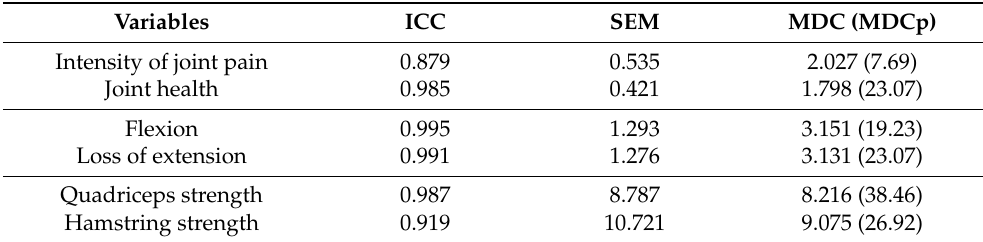
Table 3. Minimal detectable change of joint status, joint pain, range of motion, and hamstring flexibility evaluated in the different